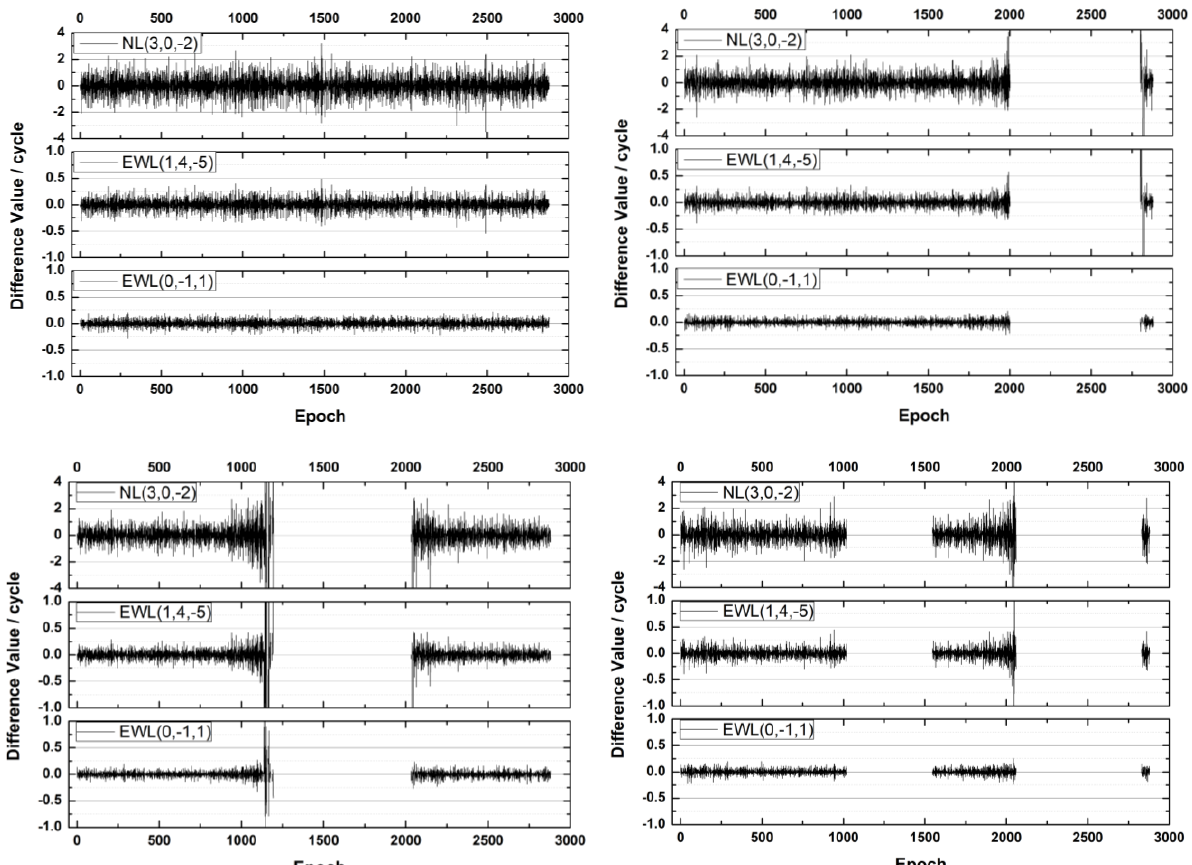
Figure 2. Combination ambiguity difference of satellite C02 、 C06 、 C13 and C16 between adjacent epoch for BDS-2 triple